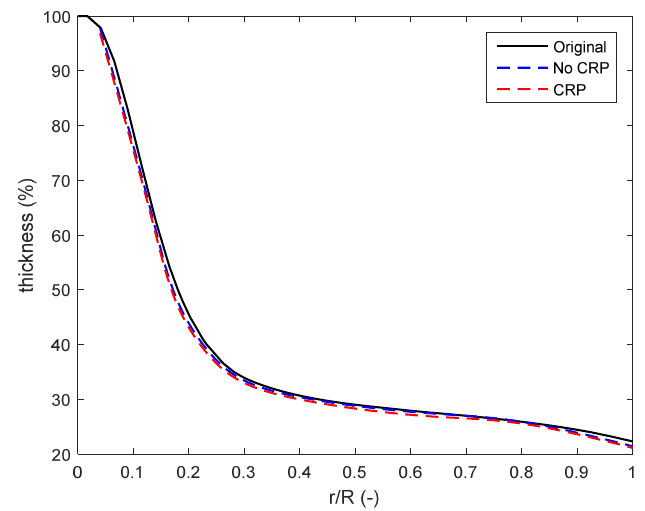
Figure 13. The comparison of thickness distributions between the optimal blades and the original one. The Weibull distributions with annual average wind speed according to corresponding hub height (95, 117.2, 119.8 m) are shown in Figure 14. The annual average wind speed of 6 m/s of Weibull scaling factor (A = 6.8) and form factor (k = 1.91) determined from meteorological data of inland China is set as the annual average wind speed at hub height of 95 m. The annual average wind speed at optimal hub heights considering rated power (119.8 m) or not (117.2 m) are 6.3288 m/s and 6.2969 m/s, respectively. The Weibull form factor is assumed to be fixed as 1.91. The Weibull distributions show that the optimal hub heights have more probability with higher wind